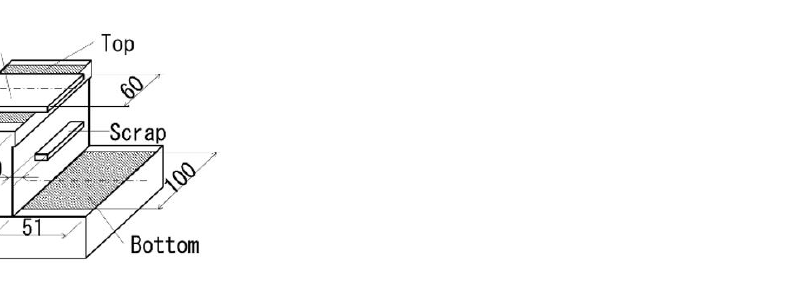
8 of 10 Figure 12. Effect of tensile strength of the steel sheet on the mass of shearing slivers. The conditions for measuring the scattering mass of the shearing slivers during con-